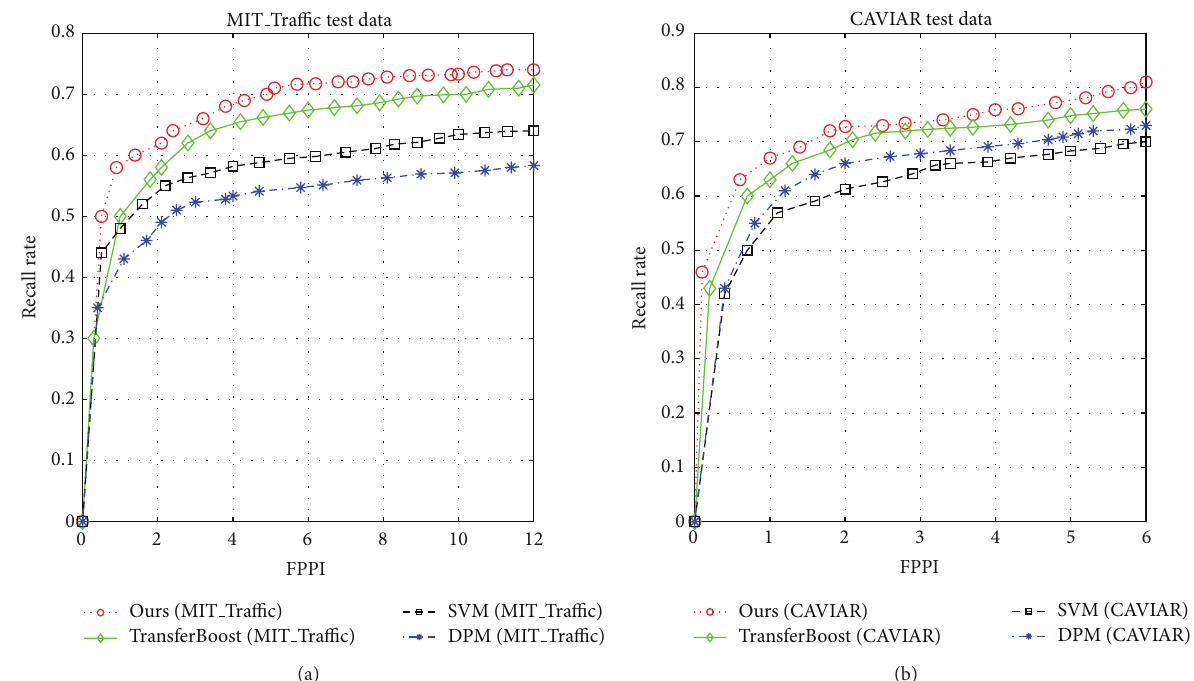
Figure 3: Comparison with TransferBoost, linear SVM, and DPM on MIT Traffic scene (a) and CAVIAR (b)